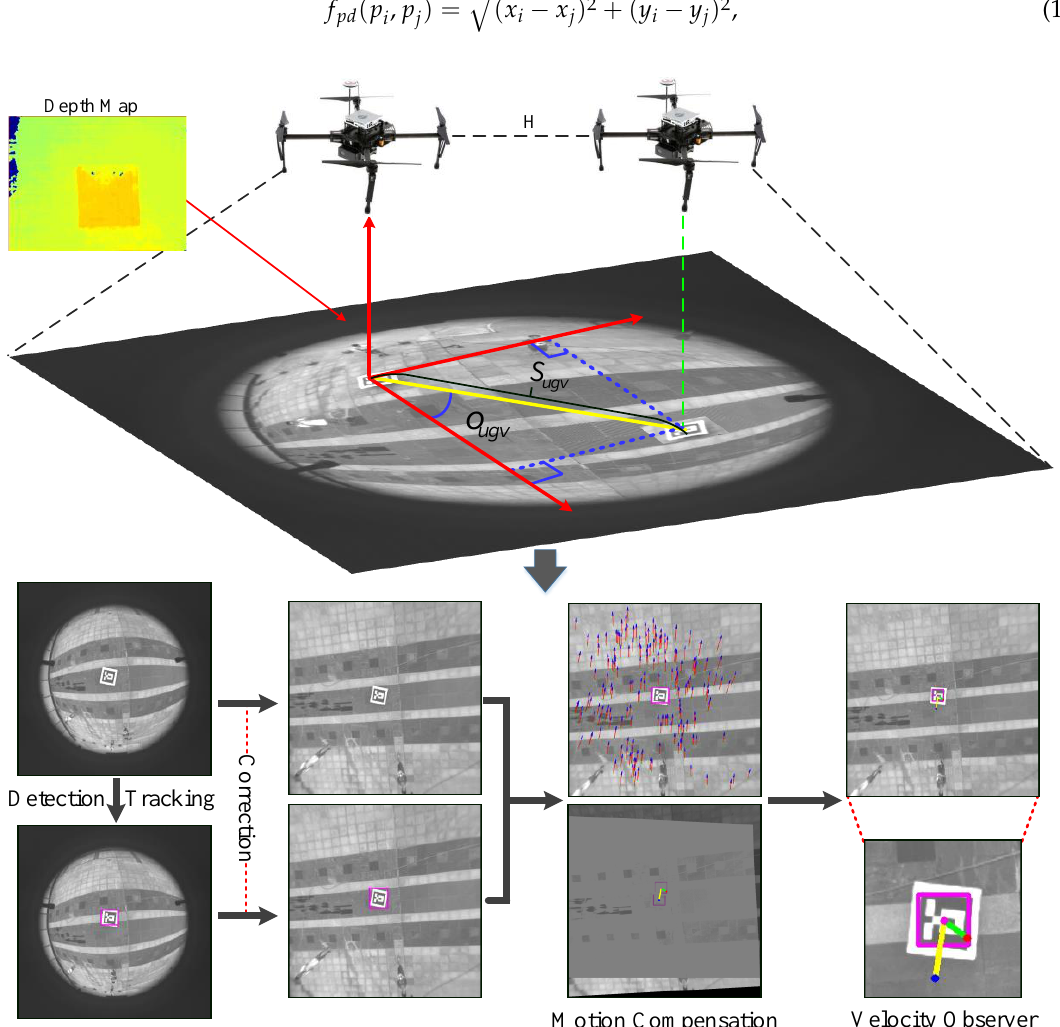
Figure 5. An illustration of the proposed UGV state estimation method. It includes three parts: detection and tracking, motion compensation, and velocity observer. The yellow and green lines in the velocity observer represent the UGV’s actual movement and the distance between the UAV and UGV,